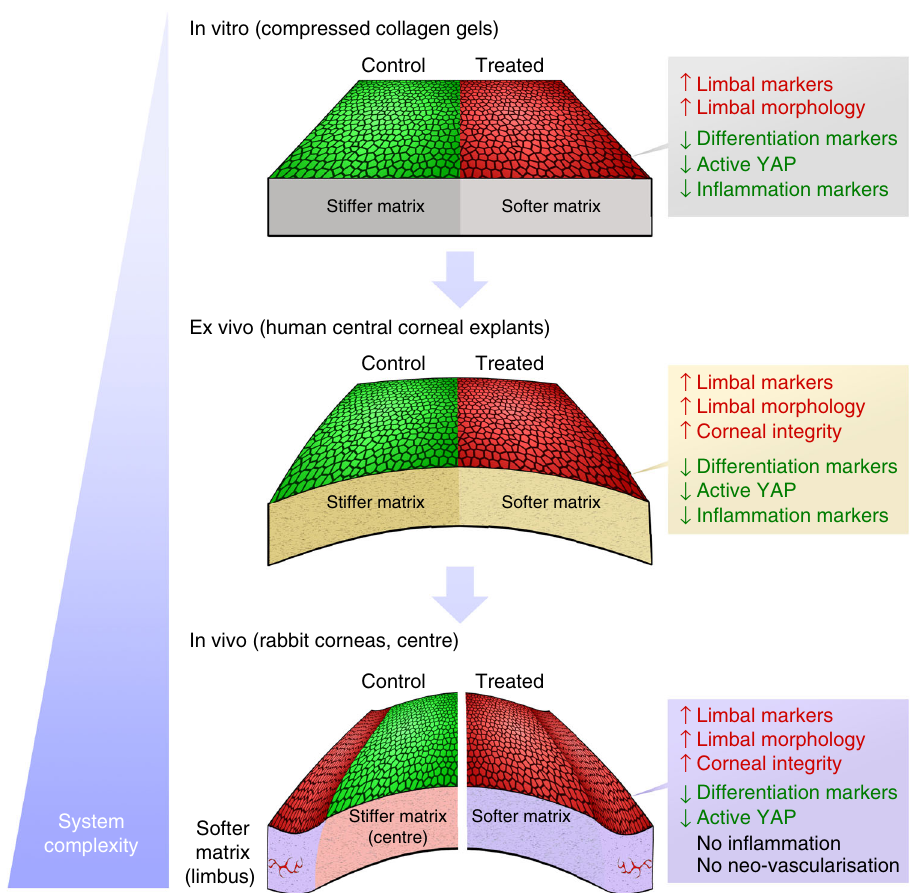
Fig. 8 Consistency of overall results from the multiple experimental model systems under study. Epithelial cells (re)populating collagenase-softened (treated) substrates expressed signi fi cantly higher levels of limbal markers and lower levels of differentiation and active mechanotransduction markers compared to the untreated (control) tissues, independently of the system ’ s degree of complexity (i.e., topography, biochemical composition). In addition, the maintenance of limbal cell morphology and failure to elicit major pro-in fl ammatory responses after tissue softening were similarly observed for all in vitro, ex vivo, and in vivo experiments. The comparable results obtained on both simple and complex substrates supported the notion that the cellular effects were derived from the modulation of tissue biomechanics, and not due to tissue topography or composition (i.e., exposure to cryptic biochemical cues or growth